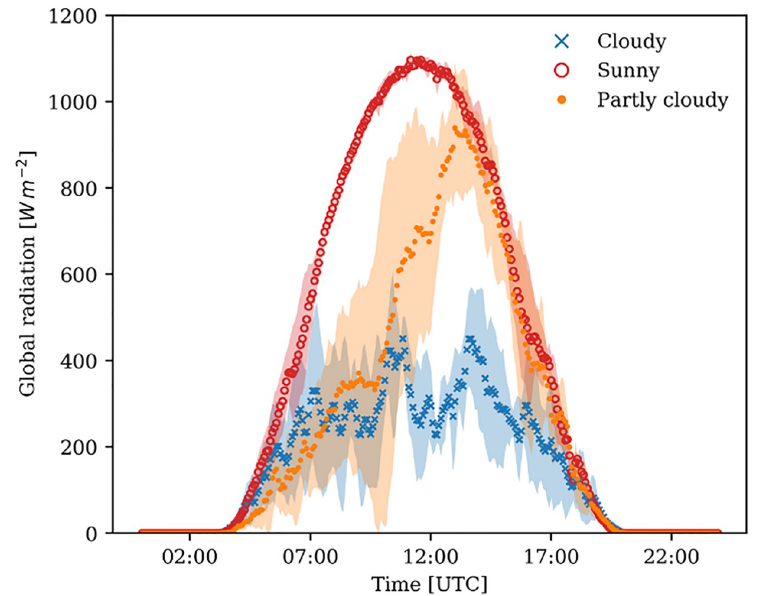
Fig 2. Global radiation outside the greenhouse. Data averaged for 5 sunny (red), 4 cloudy (blue), and 4 partly cloudy days (orange). The dotted lines represent the averages, and the shaded area the standard deviation of the specific weather